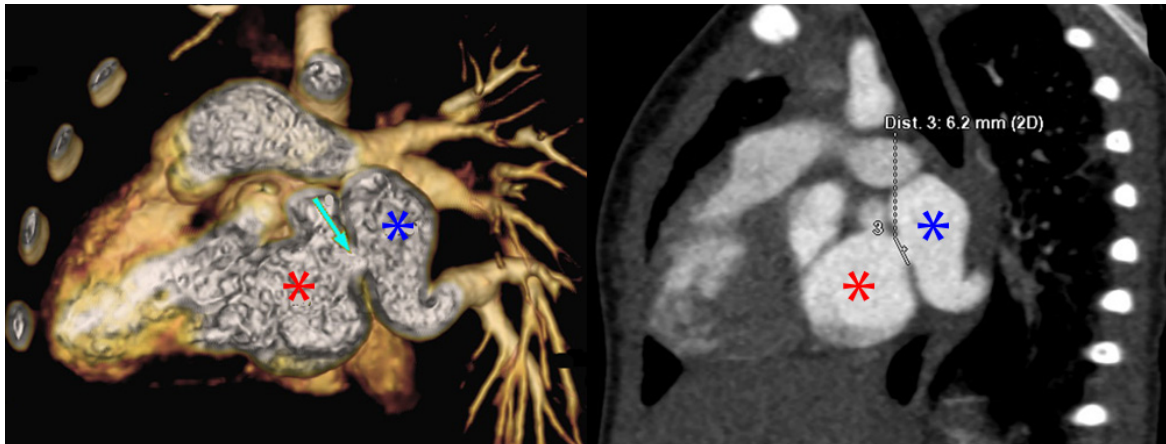
Figure 2. CT scans from the above described patient from Malaysia with repaired supracardiac TAPVR with recurrent PVS. The image on the left is a 3D reconstruction of a CT angiogram. The blue star denotes the pulmonary vein confluence, the red start denotes the left atrium. The light blue arrow on the left image denotes the area of stenosis. The image on the right that of the traditional CT angiogram with blue and red stars denoting the pulmonary veins and left atrium, respectively. The line measures the stenosis at 6.2 mm. Cross sectional imaging such as this allows institutions to risk stratify cases and offer surgery to those patients with the best predicted outcome.